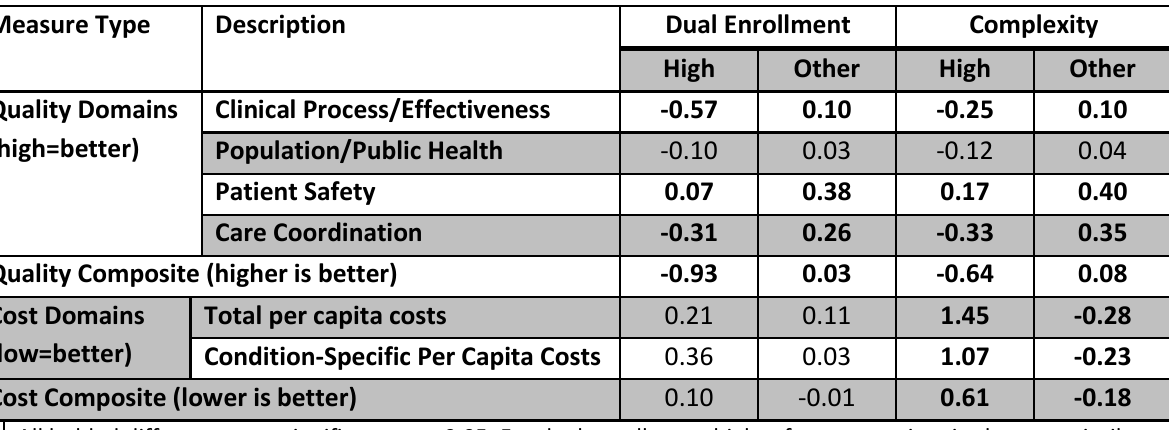
Table 10.12. Practice-level Performance on Cost and Quality Domains and Composites, Stratified by High-Dual or High-Complexity Practice vs. Other Practice